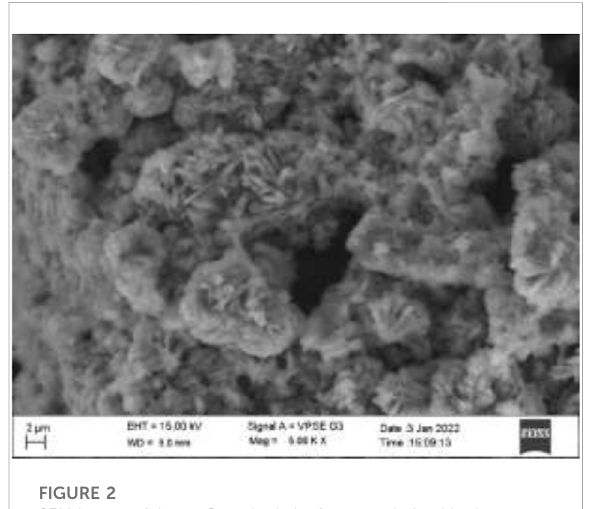
FIGURE 2 SEM image of Areca Catechu L. leaf extract derived hydroxy apatite nanoparticles showing nano fl ake like